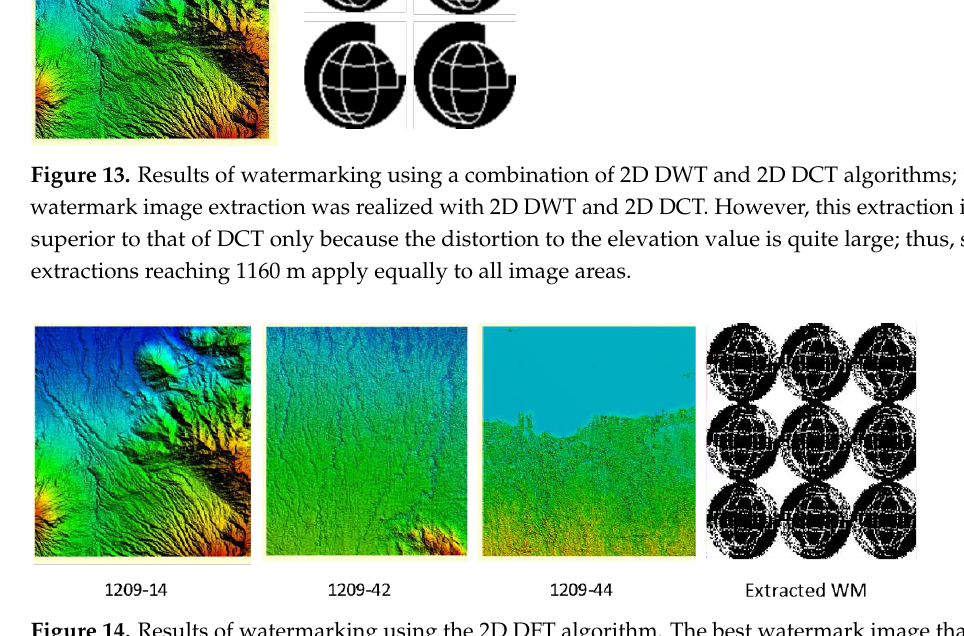
Figure 14. Results of watermarking using the 2D DFT algorithm. The best watermark image that can be extracted with DFT is 94.21%, which is applied on the DEMNAS 1209-44.